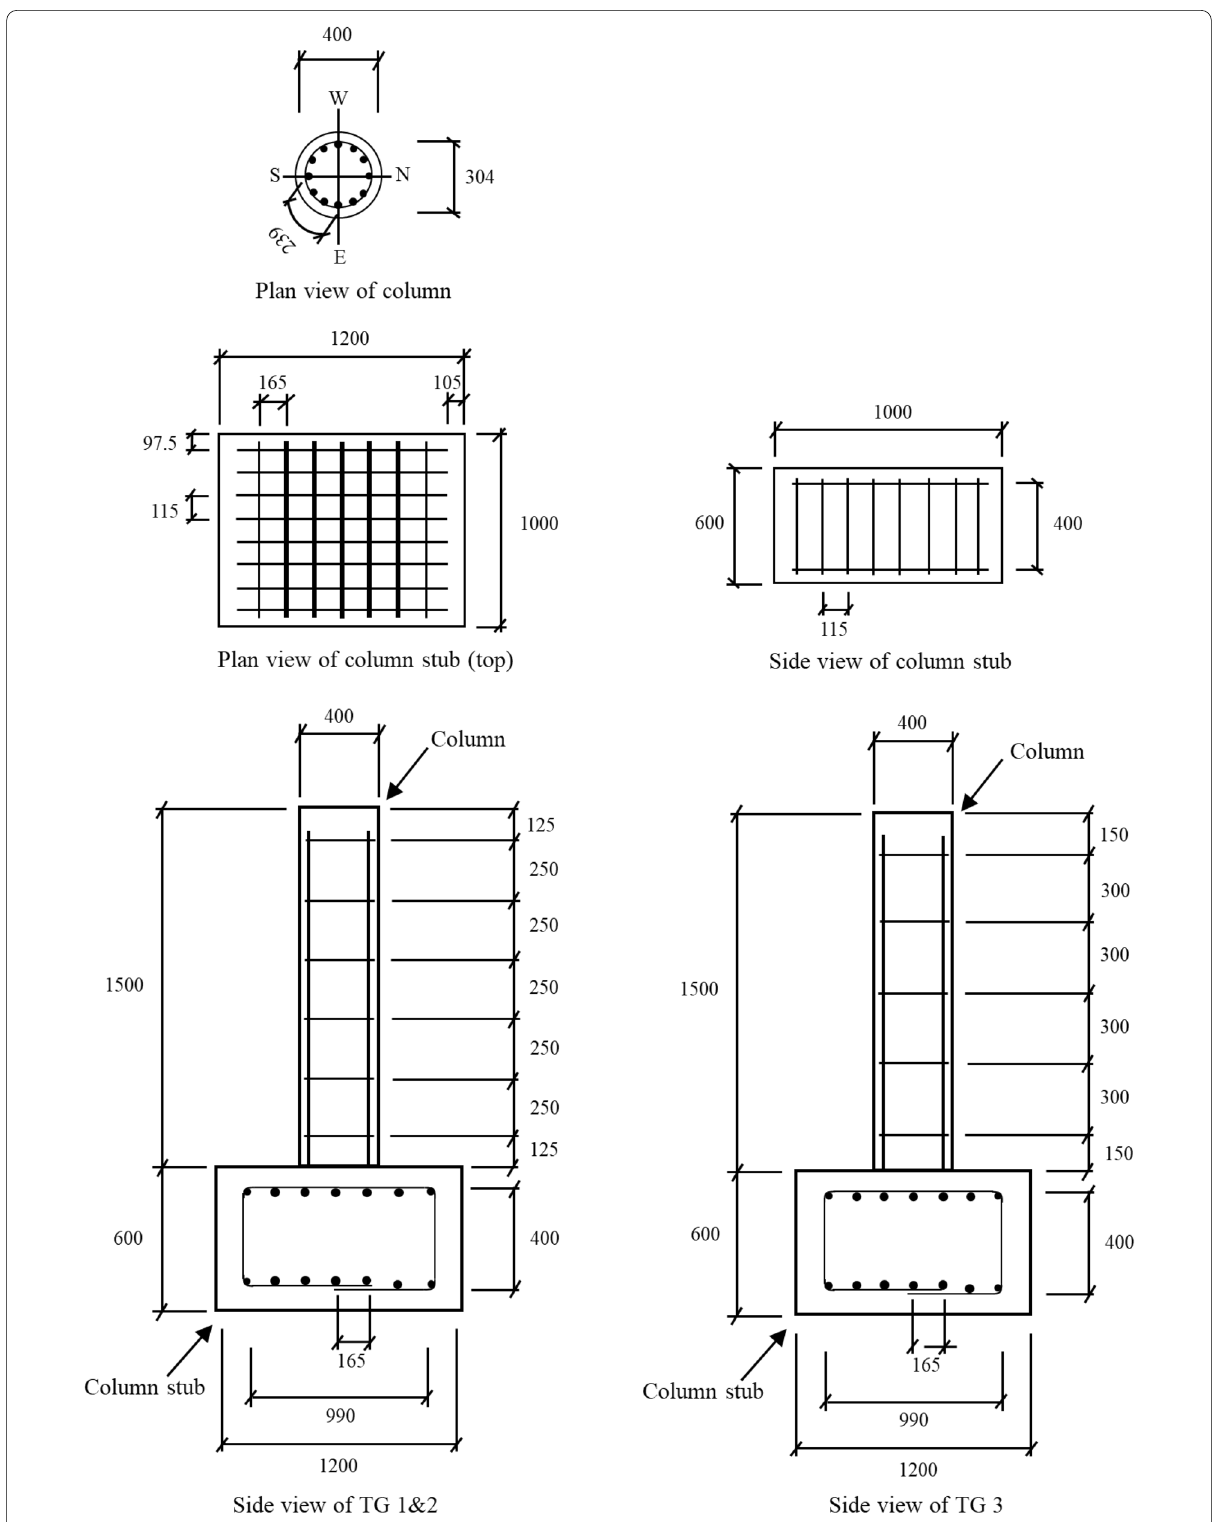
Fig. 4 Details of test specimens (Note: unit is in